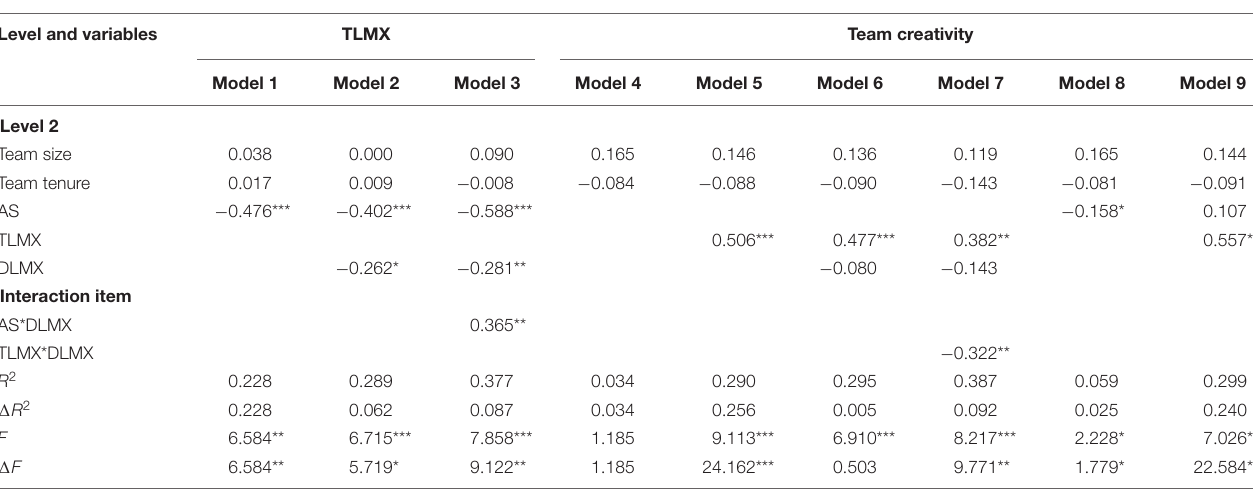
TABLE 3 | Regression results for team-level